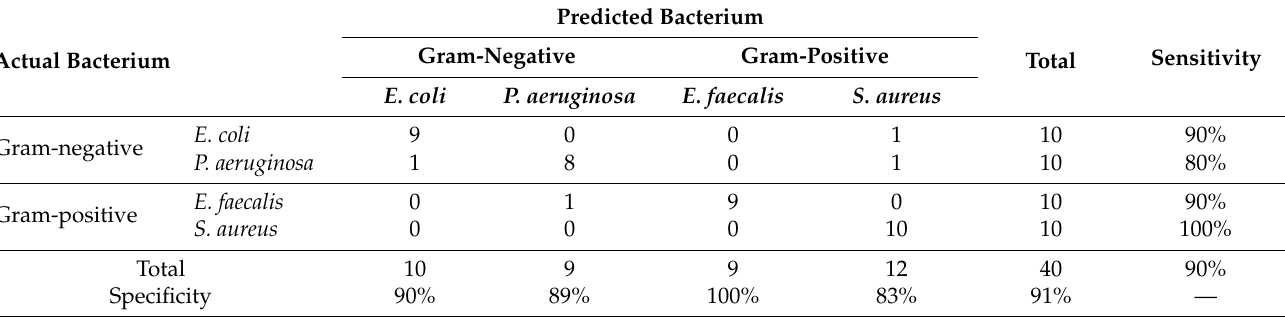
Table 2. Confusion matrix for the internal validation classification (LOO-CV) performance of the E-nose-MOS-LDA-SA model concerning the discrimination of the four studied bacteria ( E. faecalis , S. aureus , E. coli ; and P. aeruginosa ) grown in BHI agar medium. Predicted Bacterium Total SensitivityGram-Negative